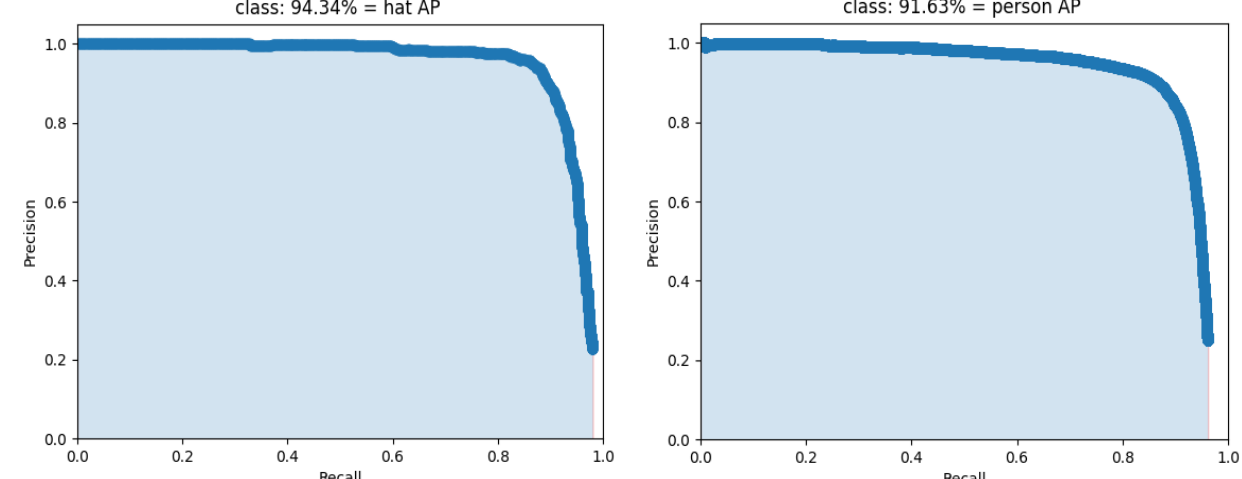
Figure 8. Precision–recall curve of the improved YOLOv4. The left image is the PR curve of hat and the right image is the PR curve of person